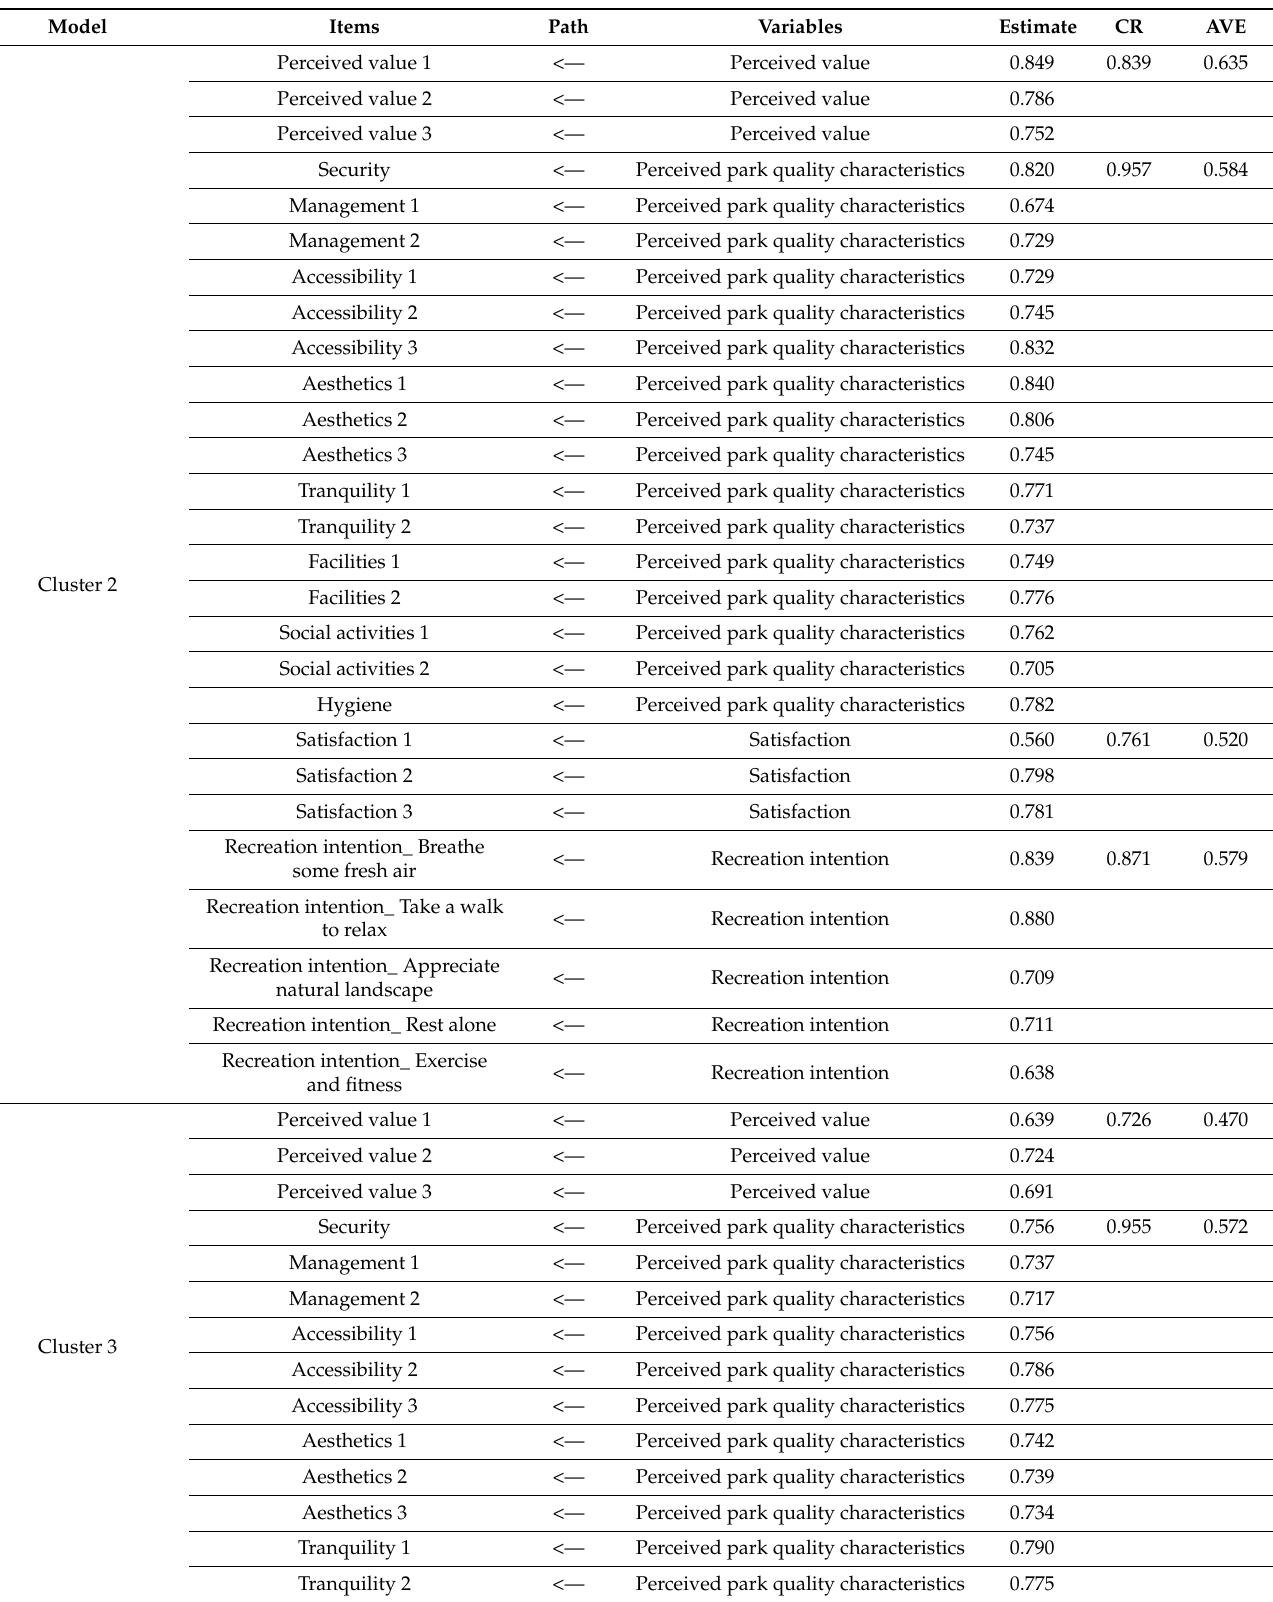
Table A6. Reliability and validity analysis by AMOS.